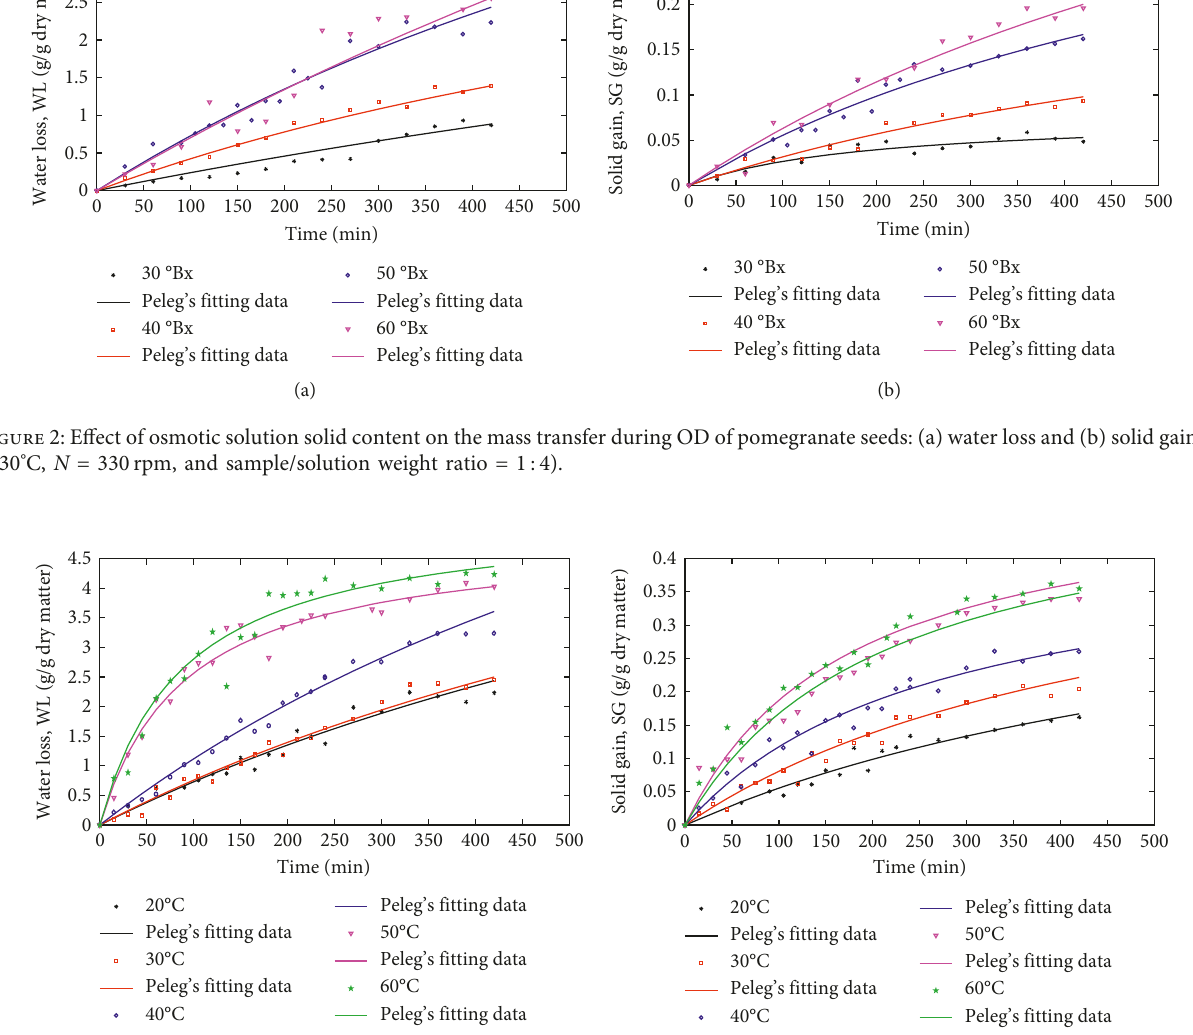
50 ° Bx, N (cid:31) (cid:31)